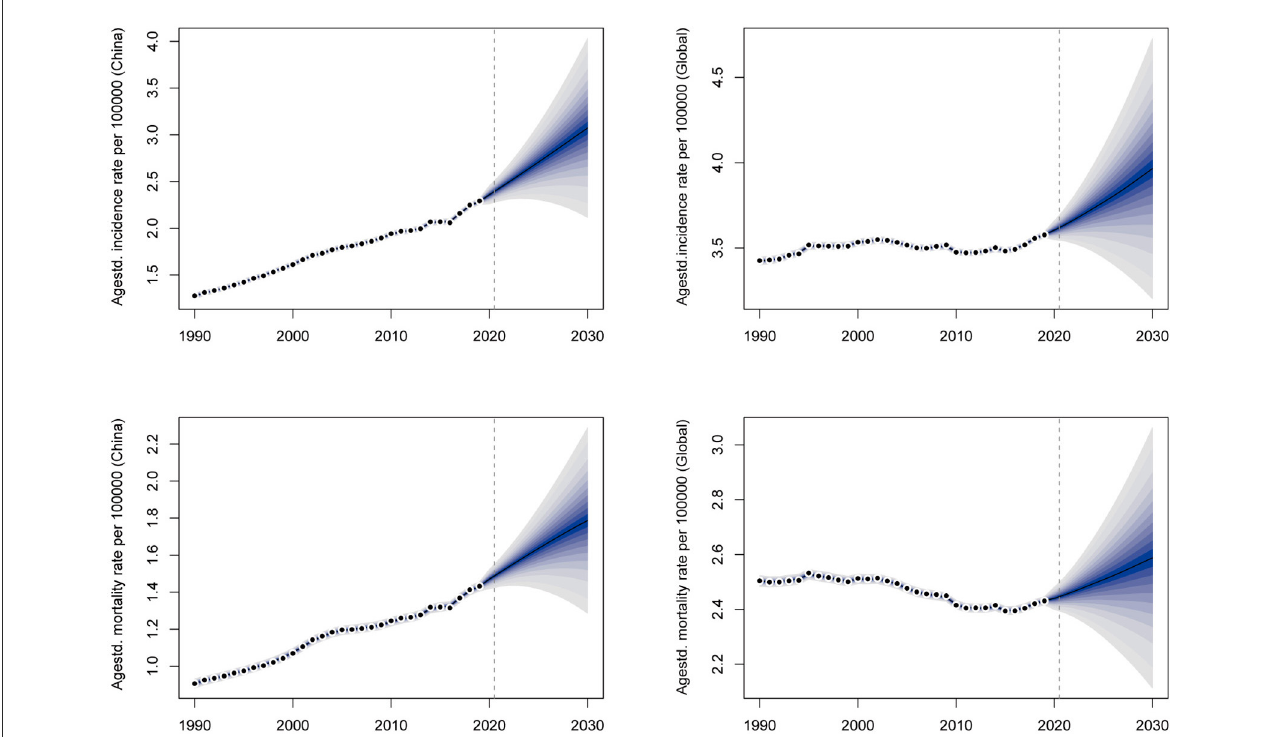
FIGURE7 The prediction of ovarian cancer incidence and mortality rates for the next 10 years in China and the global